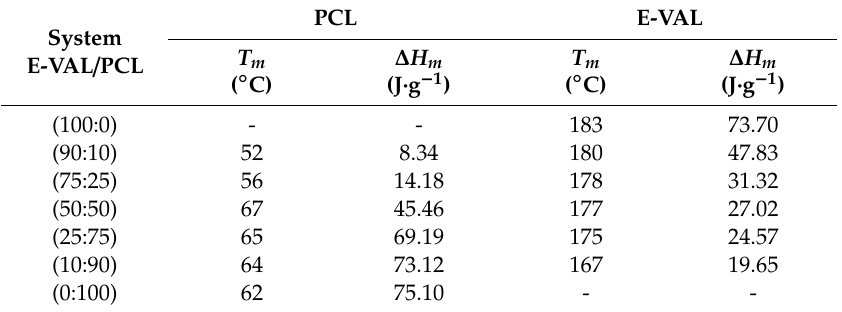
Comparative data of the melting temperatures of E-VAL / PCL blends with di ff erent